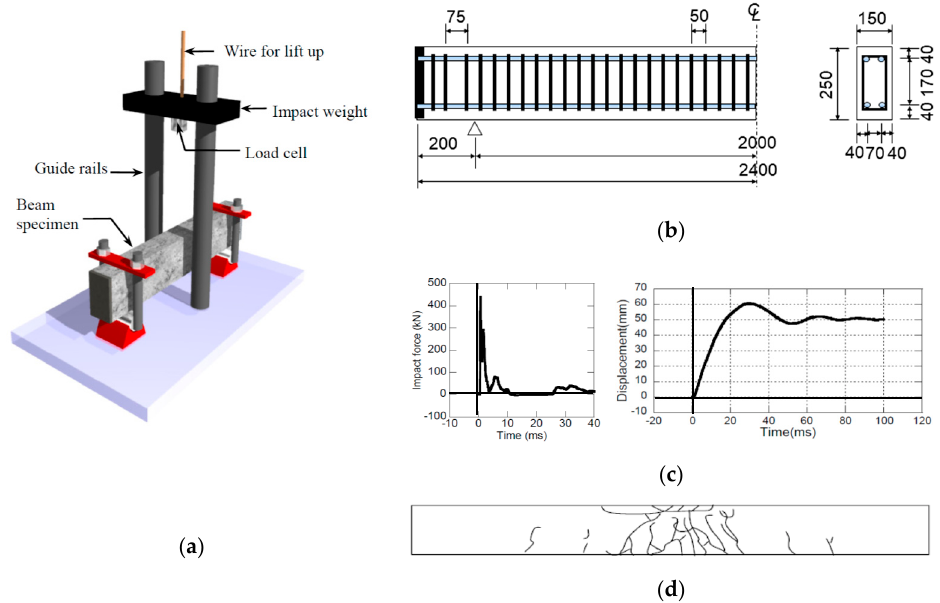
Figure 2. An example of a weight-falling impact test and its results; ( a ) Setup, ( b ) dimensions of the RC beam, ( c ) time histories of impact force and deflection, ( d ) crack pattern after the experiment.